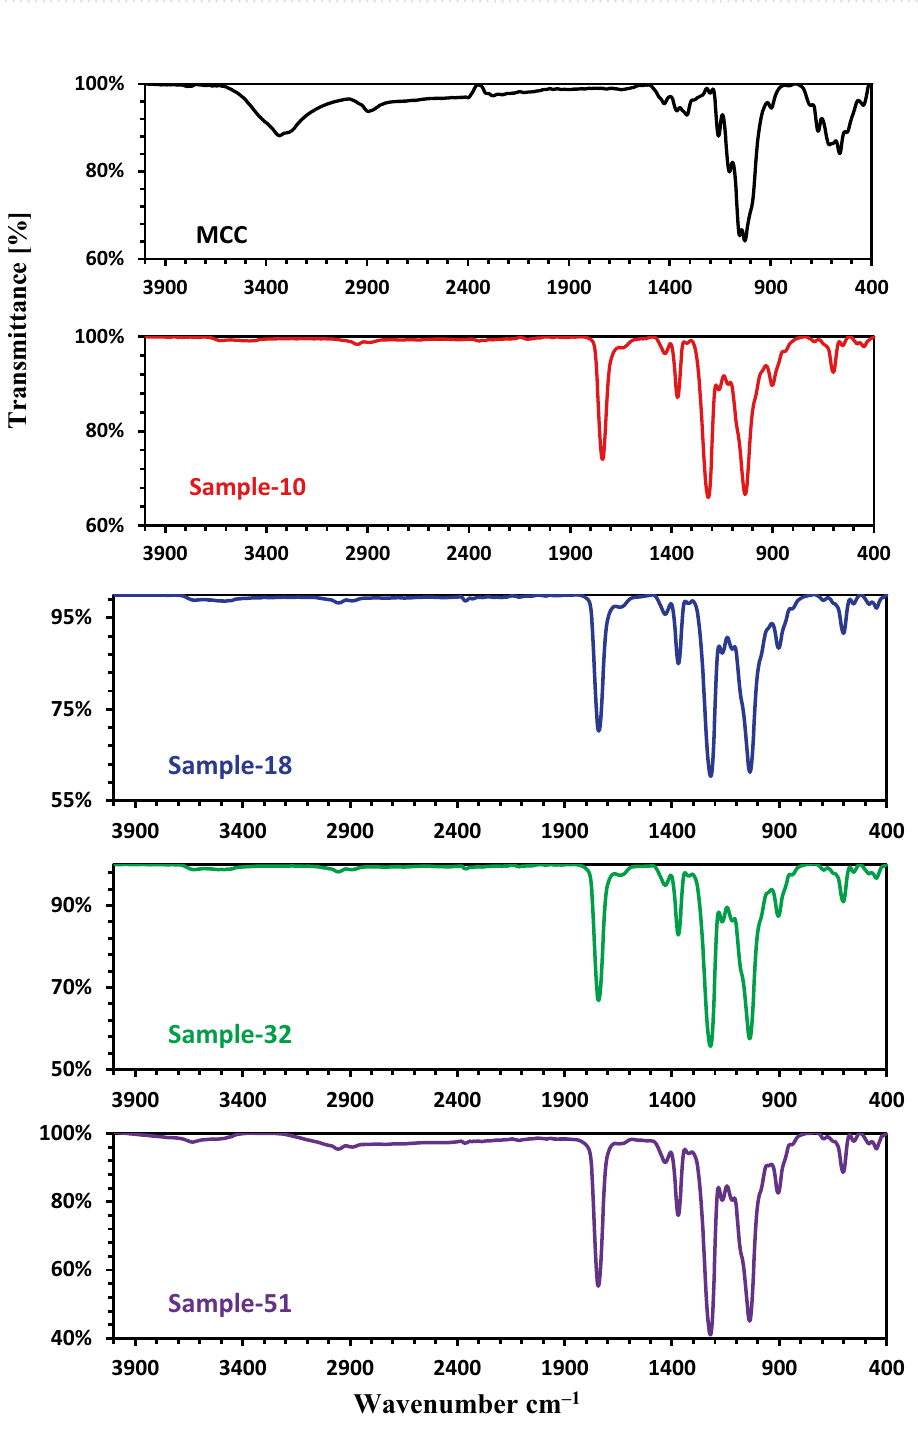
Figure 1. FTIR analysis of samples 10 , 18 , 32 , and 51